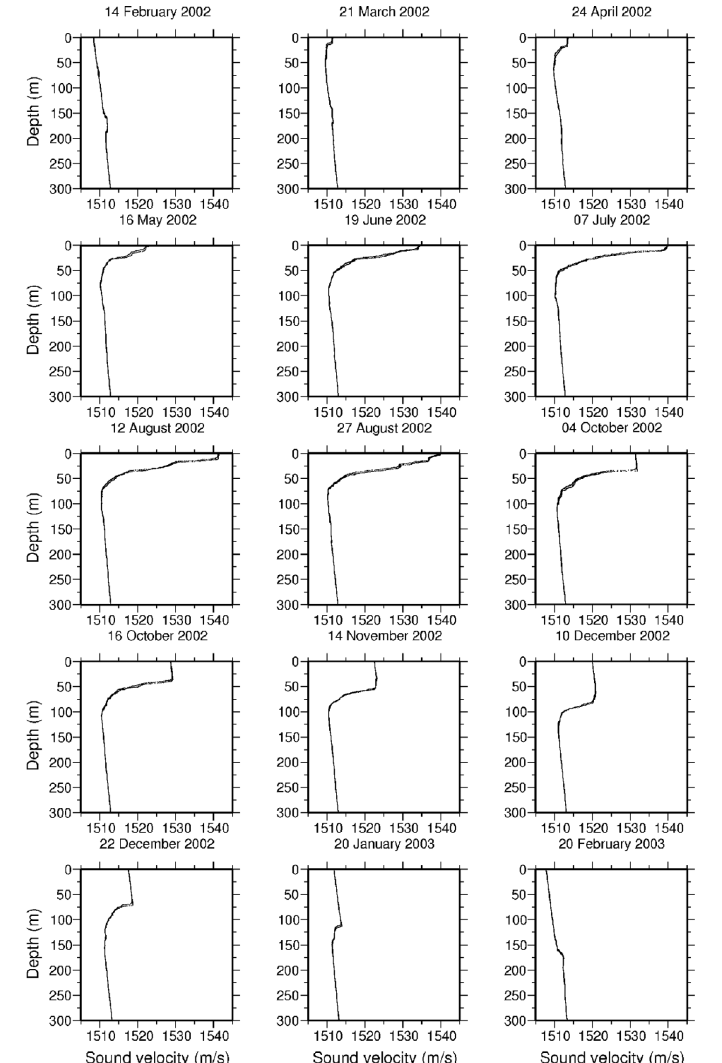
Fig. 4. Velocity profiles in the Gulf of Naples calculated from the salinity and temperature data obtained from the measurements carried out between February 2002 and February